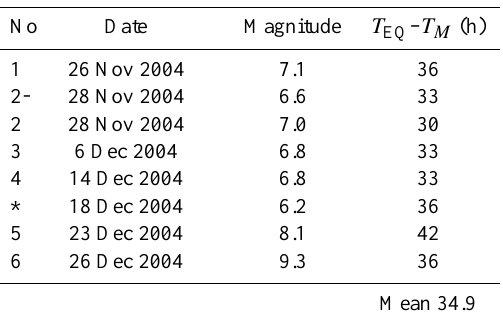
Table 3. Time difference 1t = T EQ – T M between the earthquake occurrence time and the time of the last maximum K p value be- fore the corresponding EQ. The average value of the time difference 1t = T EQ – T M is evaluated to be 1t ≈ 35h, that is about one and a half days after the sudden increase of K p index.